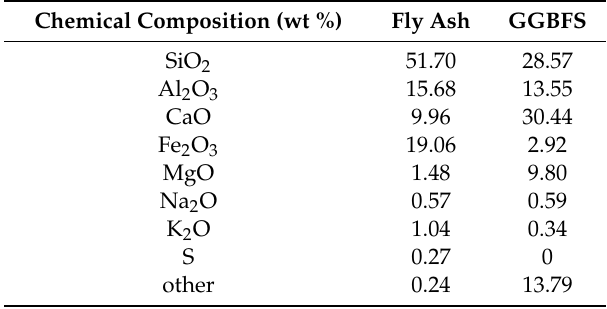
Figure 2. Initial particle distribution curves of FA and GGBFS. Table 1. Chemical components of fly ash (FA) and ground granulated blast furnace slag (GGBFS) by X-ray fluorescence (XRF)